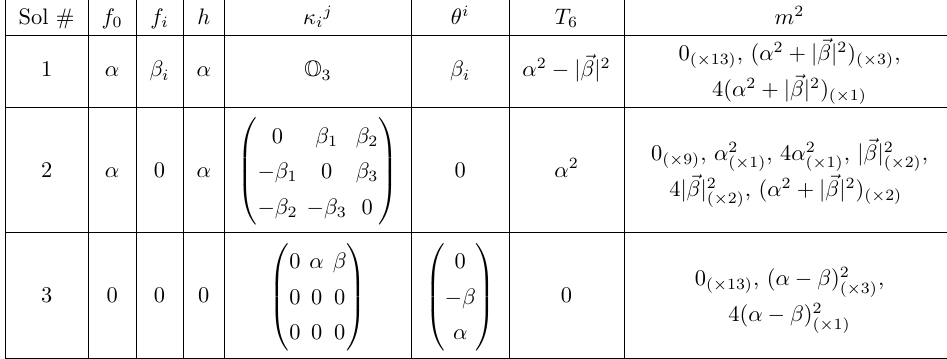
supergravity description for a gauging arising from a type IIA compacti(cid:12)cation. We (cid:12)nd that they correspond to the absence of O6/D6 sources,